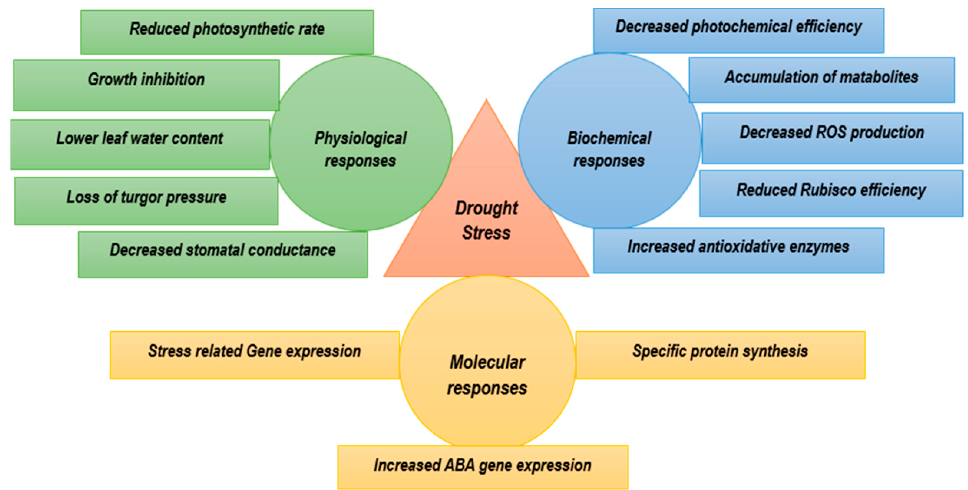
Figure 2. Physiological, biochemical and molecular responses in crop plants with water-deficit tolerance.